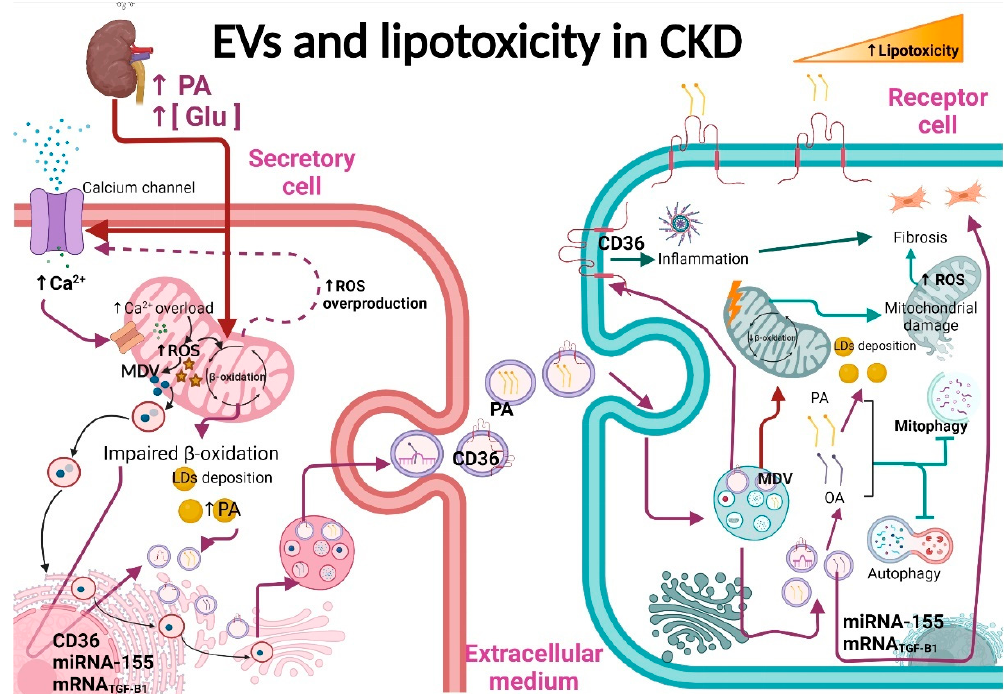
Figure 3. Extracellular vesicles (EVs) and lipotoxicity in CKD. In CKD, the increase in fatty acid levels such as palmitic acid ( ↑ PA) or high glucose ( ↑ [Glu]) concentrations favors the excretion of EVs by activation of the membrane Ca 2+ (calcium) channels; the cytosolic overload of Ca 2+ favors the uptake of this ion by the mitochondrial Ca 2+ uniporter which induces ROS production increase and mitochondrial-derived vesicles’ (MDVs) formation. High levels of PA and ROS induce β -oxidation impairment and, later, accumulation of lipid droplets (LDs) enriched with PA. The LDs’ components and proteins involved in fatty acids’ uptake, such as CD36, are loaded into EVs. Additionally, miRNA-155 and mRNA of transforming growth factor-beta 1 (TGF- β 1) are also found in the multivesicular bodies that are secreted as exosomes. Once internalized, EVs release their cargo, such as CD36, which promotes lipid uptake and inflammation in recipient cells. The components of MDVs together with the lipids released in target cells, mainly PA and oleic acid (OA) fatty acids, favor the accumulation of LDs and mitochondrial impairment. Furthermore, PA accumulation also inhibits mitochondria, favoring the accumulation of damaged mitochondria and triggering fibrosis. Image created with Biorender.